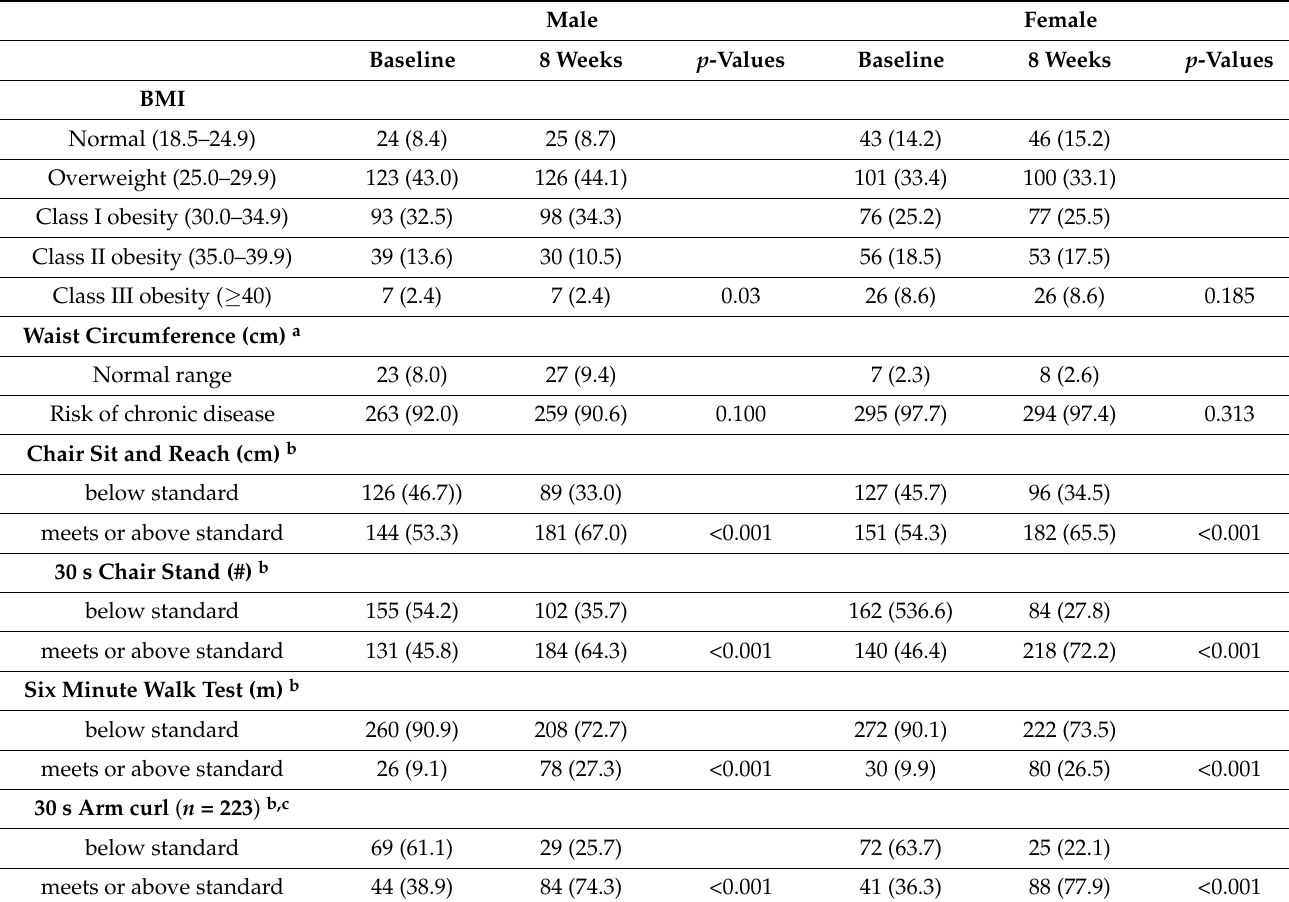
Table 3. Classification of participants at baseline and post program for clinical and fitness